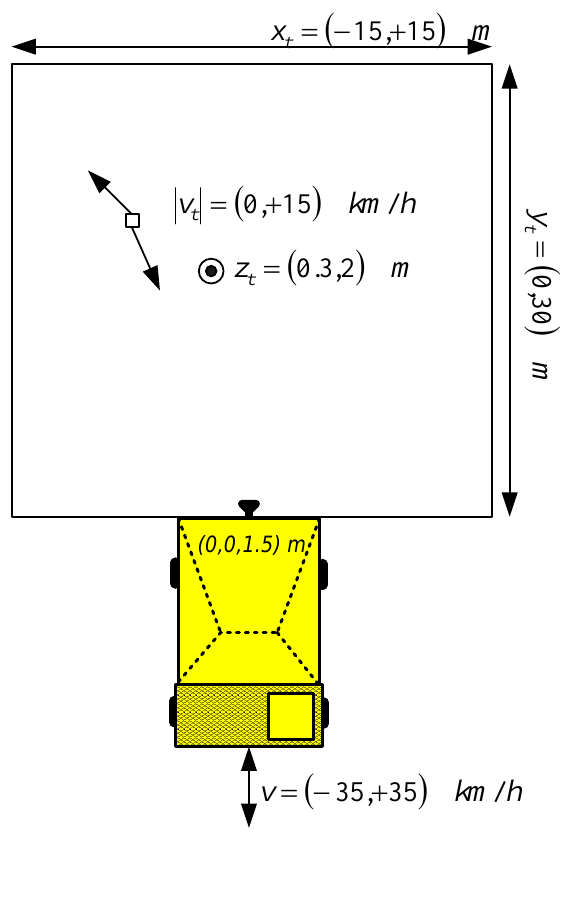
Figure 5. Scheme of the Monte Carlo